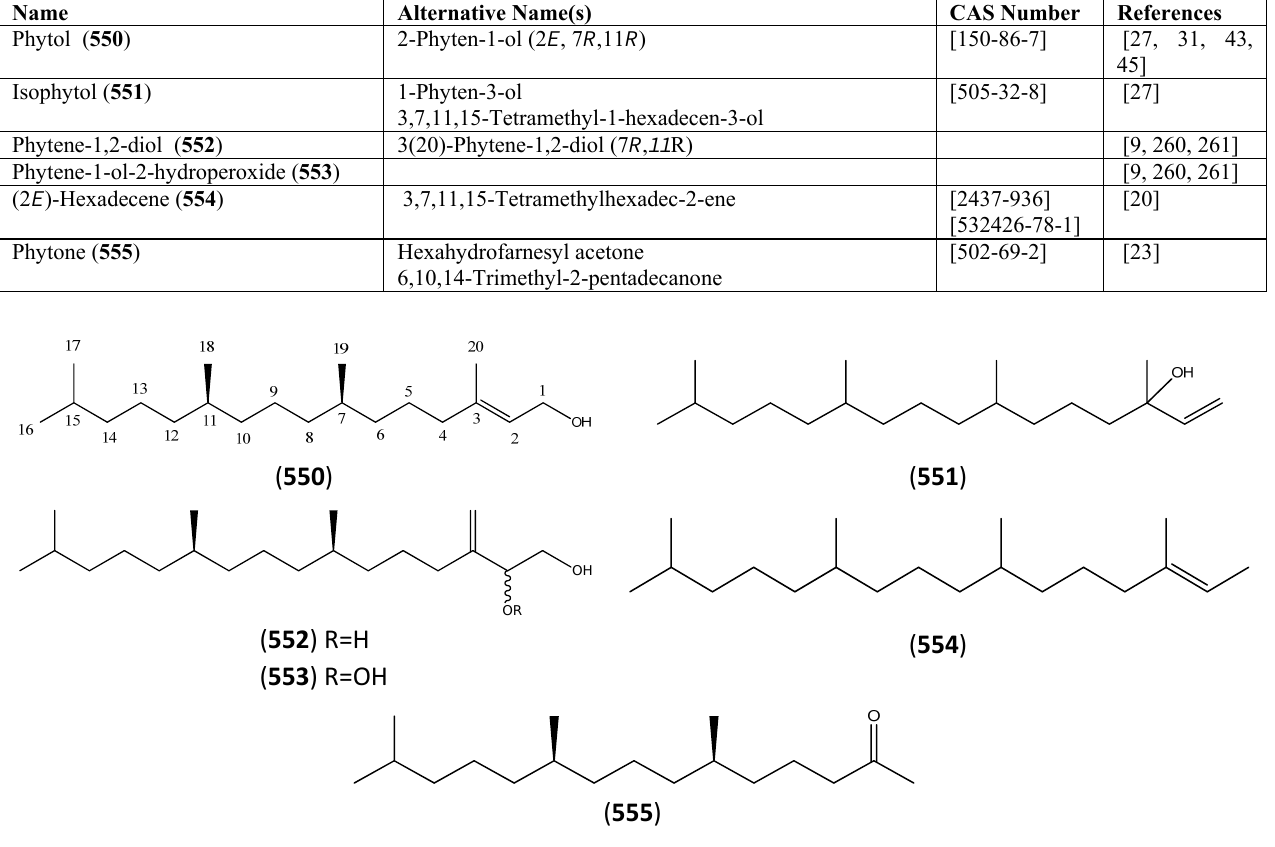
Table 42. Phytane Diterpenoids